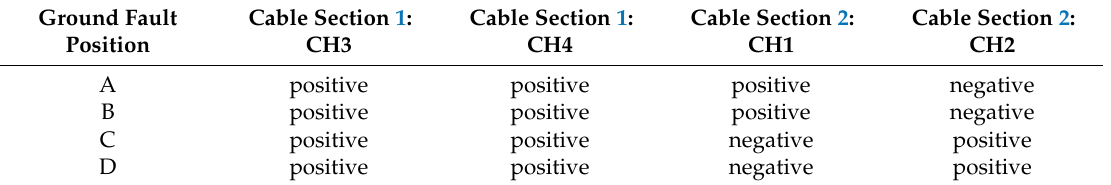
Table 9. Polarities of ground fault currents in cable without load connected.